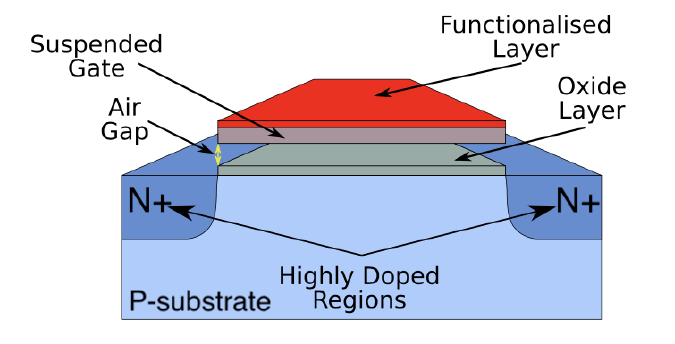
Figure 1. Schematic diagram of a hybrid nanostructure. The structure features a functionalised, suspended gate that is doubly isolated from the substrate by a thin oxide layer and by an air gap, and uses an MOSFET as a readout